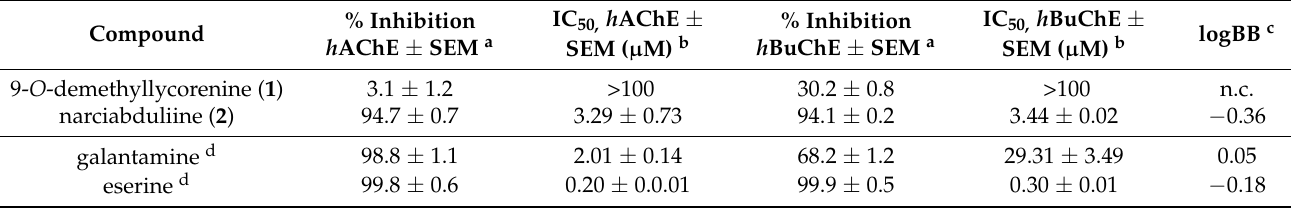
Table 1. In vitro results of human acetylcholinesterase ( h AChE) and butyrylcholinesterase ( h BuChE) assays and calculation of logBB of reported